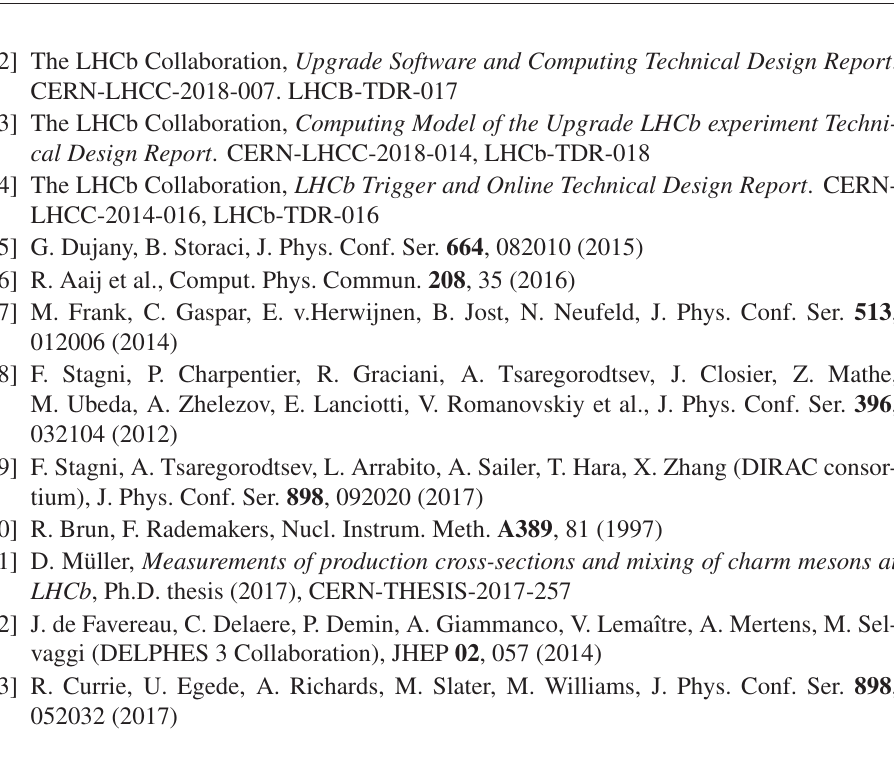
Figure 2. Logical workflow of Monte Carlo simulation in Run